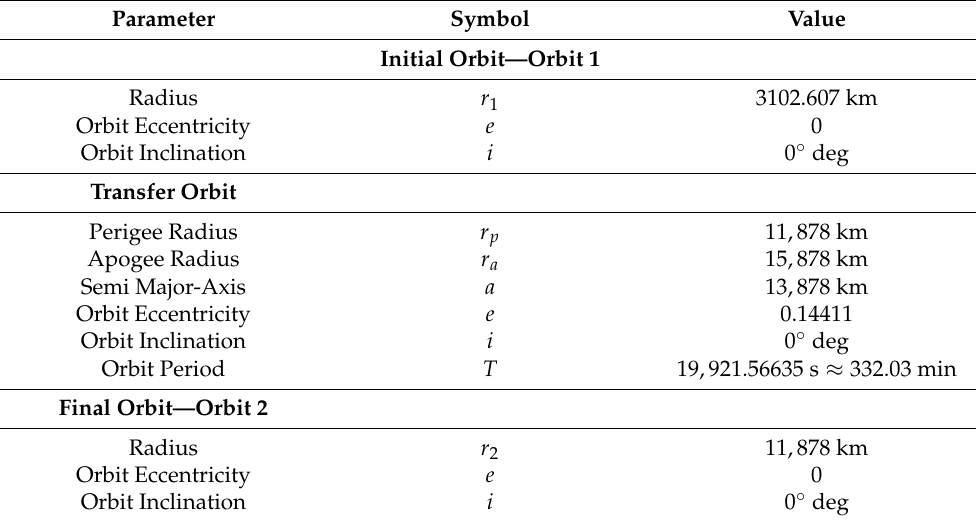
Table 2. Orbital elements for case 2: Hohmann